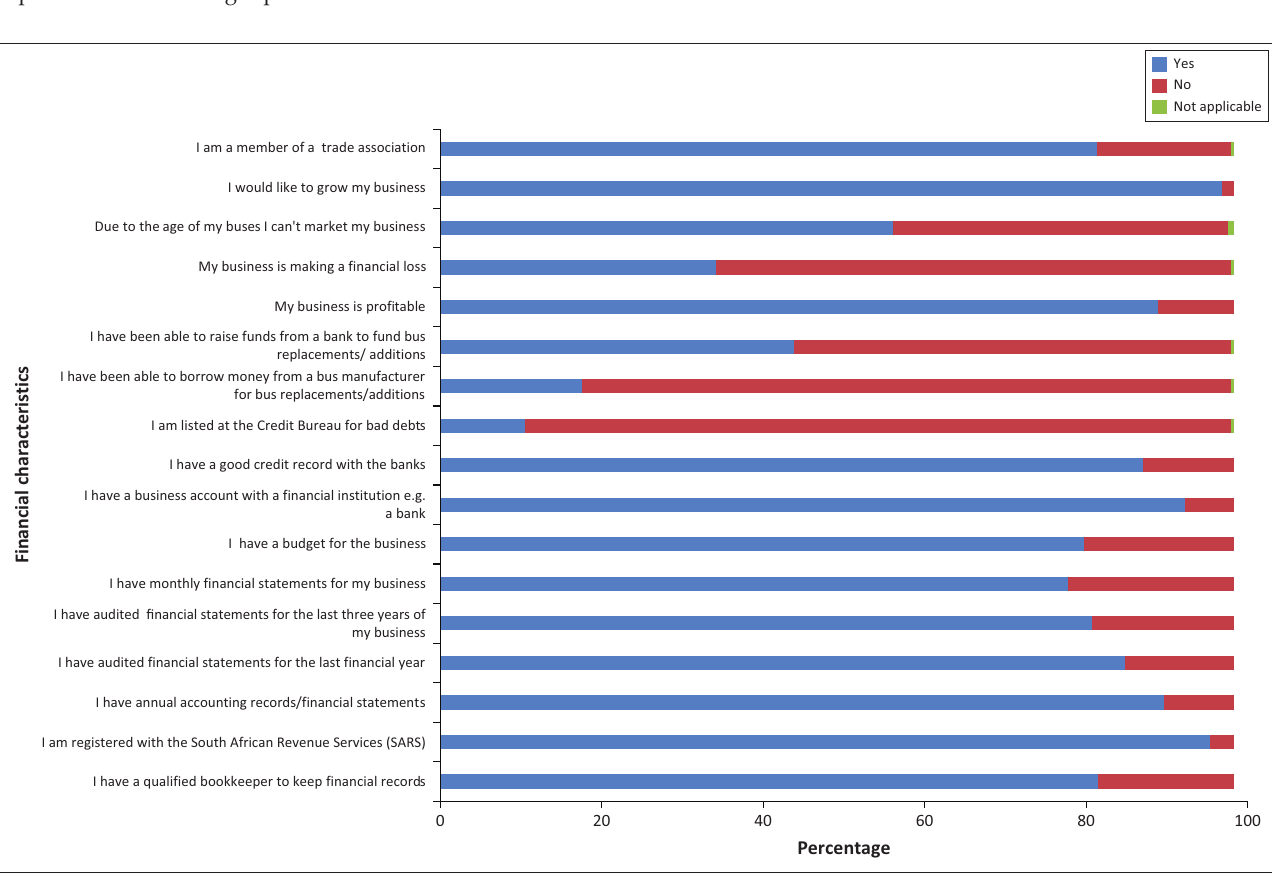
FIGURE 7: Financial characteristics of small-bus operators.